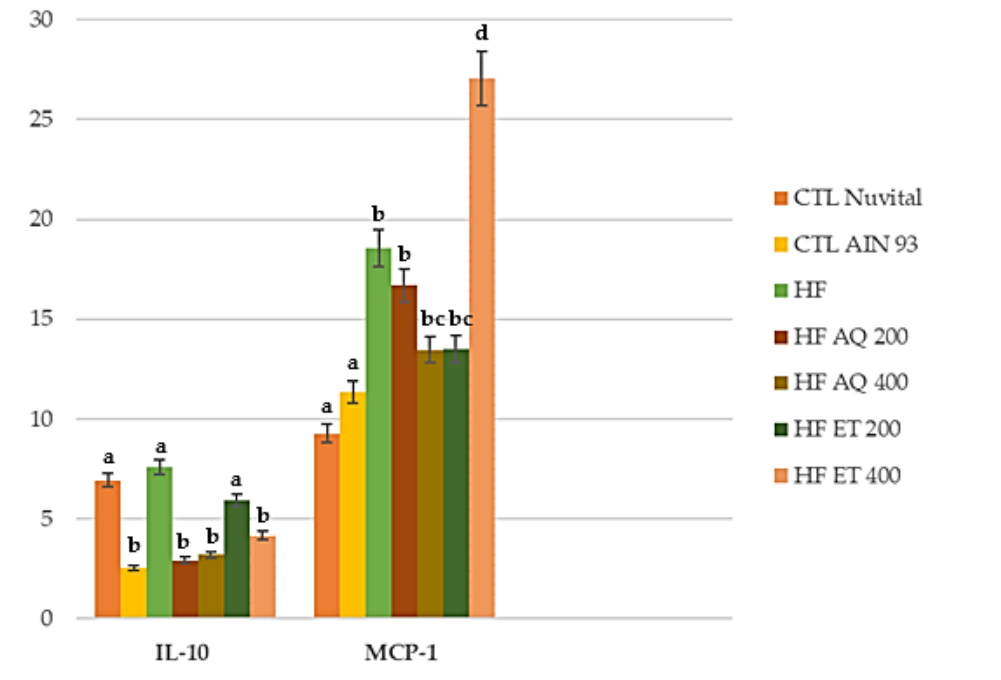
Figure 7. Quantification of IL-10 and MCP-1 (pg/mL) in animals fed a balanced or high-fat diet and supplemented with saline, aqueous extract or ethanol extract of G. gardneriana leaves per day for 8 consecutive weeks. Values expressed as mean ± standard deviation. Different letters indicate a significant difference between groups and groups with the same letter are not significantly different. p < 0.001; n = 6 – 11; ANOVA followed by Tukey post-test.